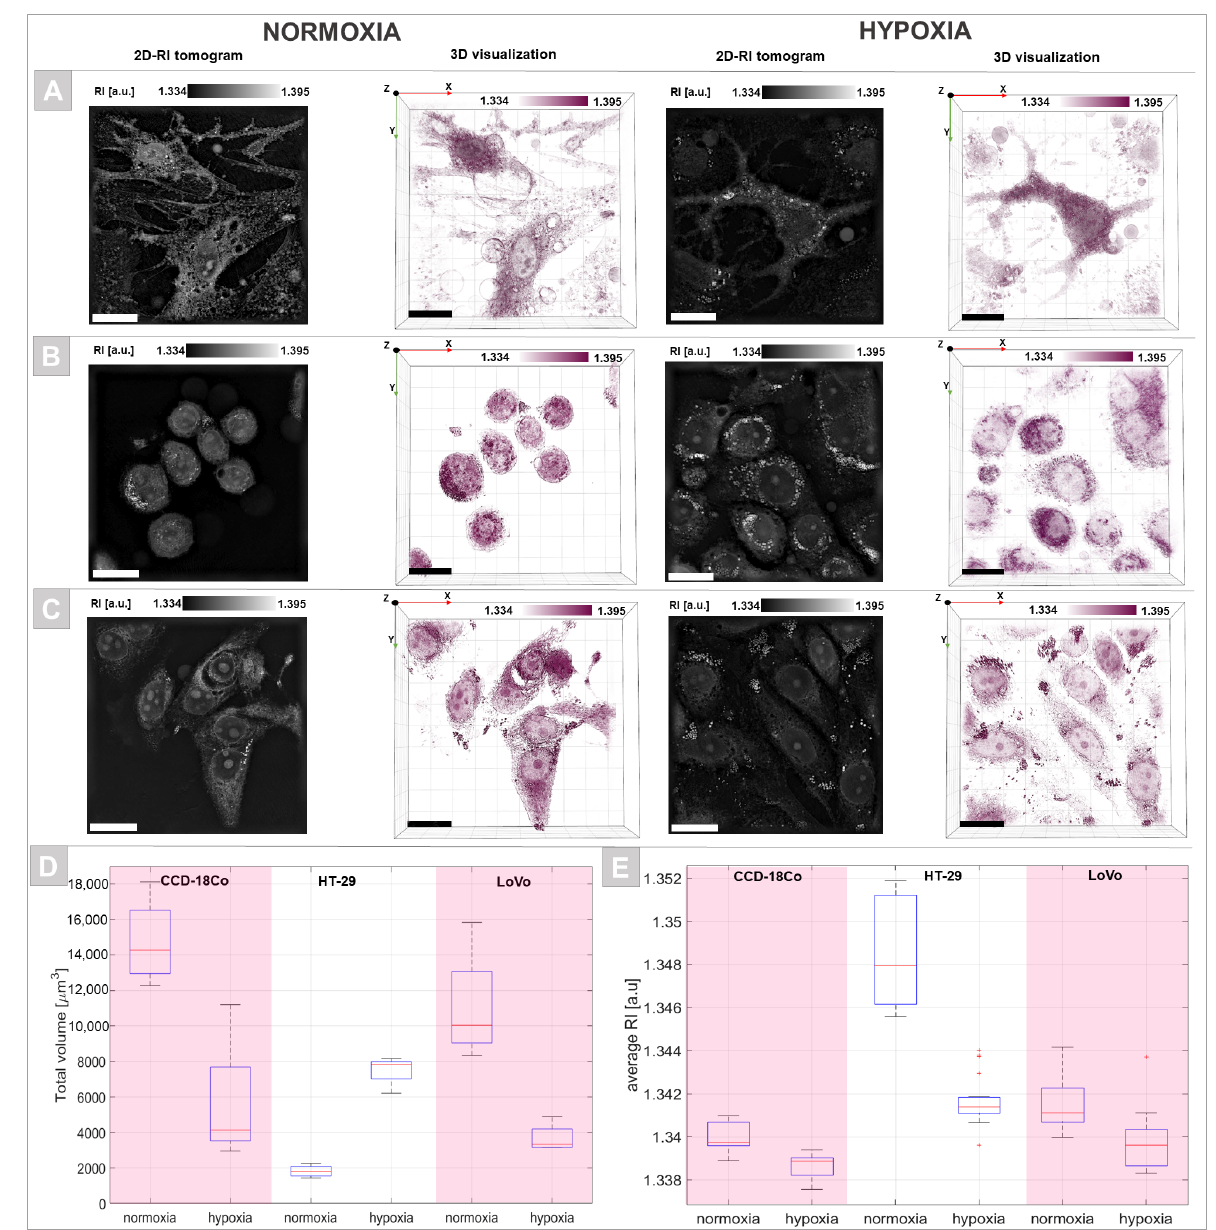
Figure 4. A comparison of the representative 2D-RI tomograms and 3D visualizations (scale bars: 20 µ m) of CCD-18Co ( A ), HT-29 ( B ), and LoVo ( C ) cells under normoxic and hypoxic conditions. The variation of single-cell total volume ( D ) and average RI value of cells ( E ) was also